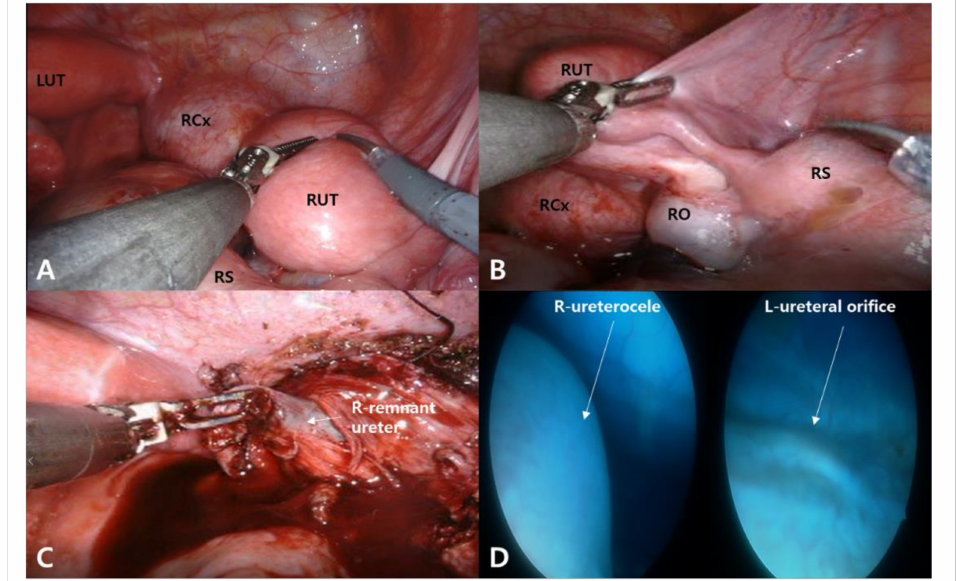
Figure 1. Robot-assisted laparoscopy revealed uterine didelphys. ( A ) A right cervix (RCx) was filled with hematoma and the cervix was obstructed. Ipsilateral hematometra in right uterus (RUT) with hematosalpinx in right salpinx (RS) and normal hemiuterus of left uterus (LUT) were noted. ( B ) Several endometriotic spots on right tuboovarian surface with pelvic adhesions were noted. ( C ) A dilated tubular structure of 15 mm, filled with old blood was noted on the right side of the hysterectomy site. ( D ) Cystoscopy after intravenous injection of indigo carmine dye revealed a right ureterocele and normal left ureteral